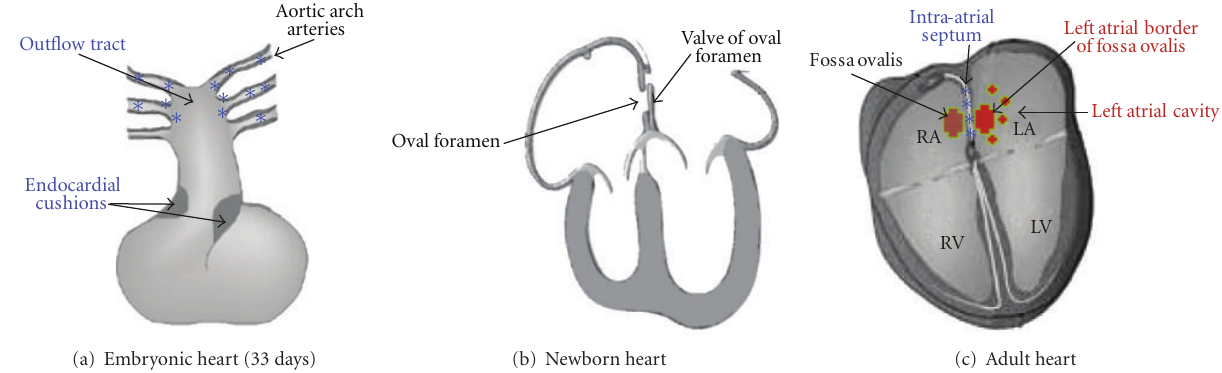
Figure 4: Neural crest embryological remnants in the adult heart and localization of cardiac myxomas. (a) Embryonic heart. Blue stars indicate the localization of neural crest cells from the pharyngeal mesoderm, which migrate through the aortic arch arteries to the outflow tract and the endocardial cushions. (b) Newborn heart. The Fossa ovalis in the adult heart is an embryonic remnant of the foramen ovale, which closes shortly after birth. (c) Adult heart. Red crosses indicate the attachment of HSV particles to cardiac myxomas. Blue stars indicate autonomic nerve fibers. RA: right atrium, RV: right ventricle, LA: left atrium, and LV: left